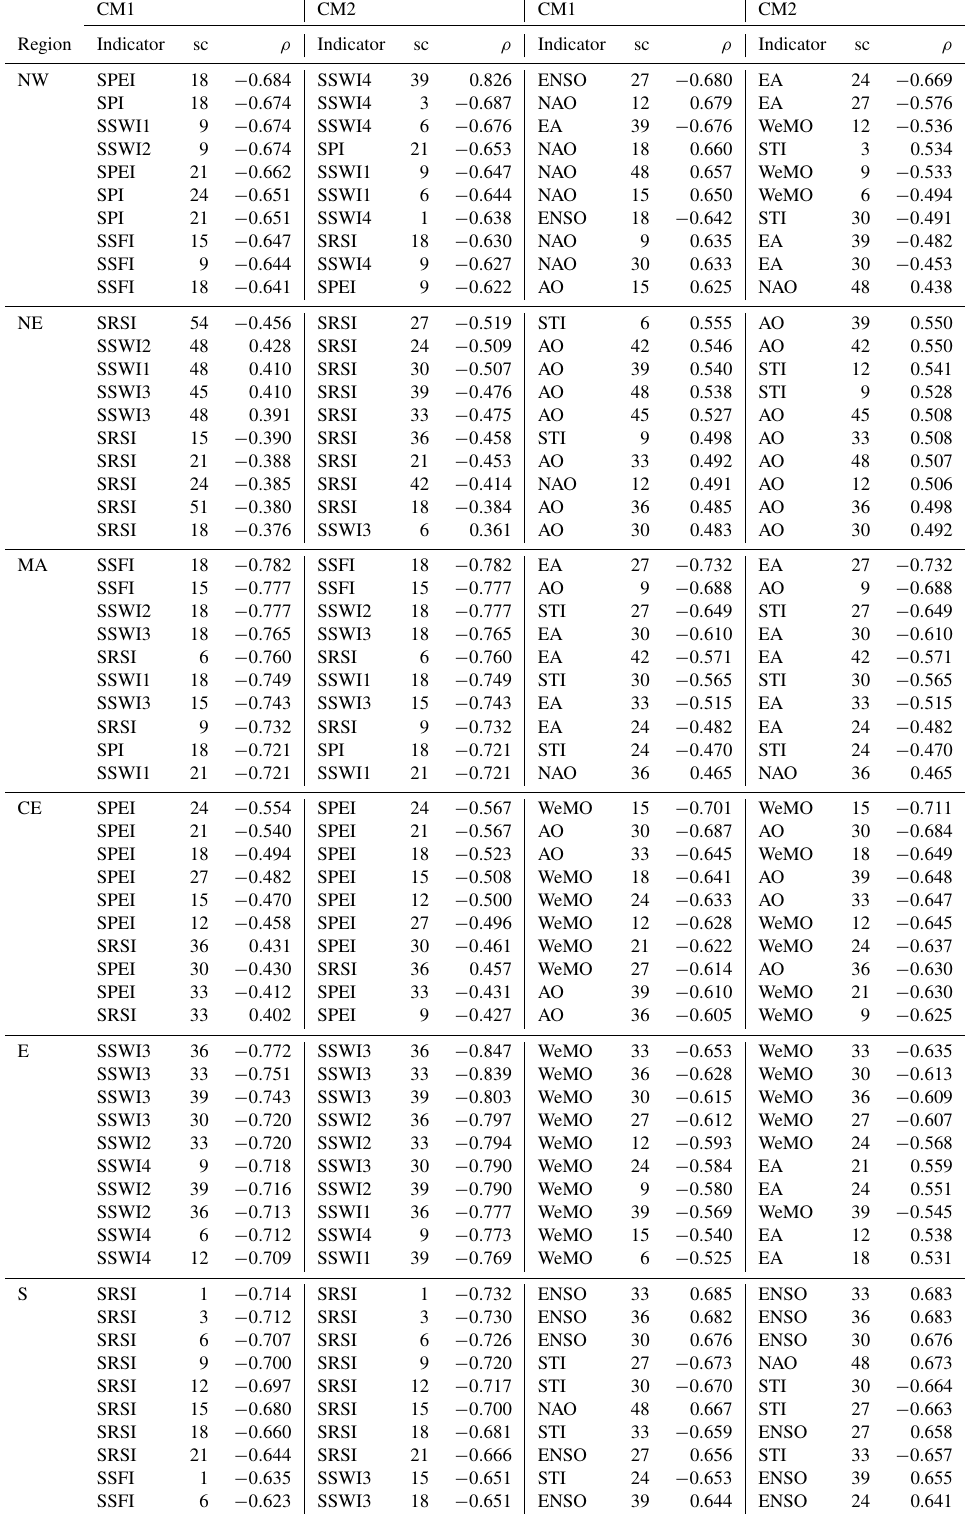
Table 3. Correlation coefficients ( ρ ) between drought indicators and climate indices, and impact occurrences for the two most censoring counting methods (CM1 and CM2). The indices are ordered by decreasing correlation strength and the timescale at which the indices are aggregated (sc) is